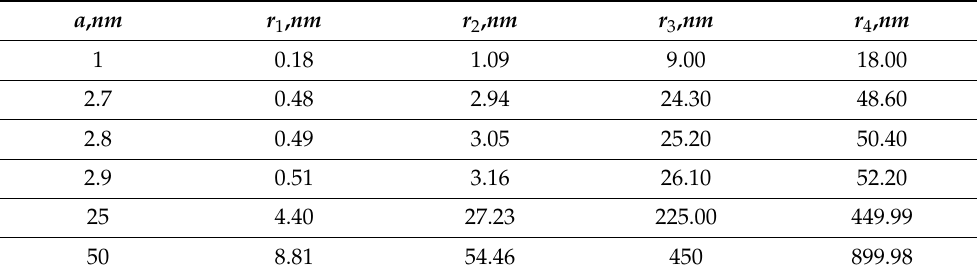
Table 1. Assessment of the radius size of the four pore